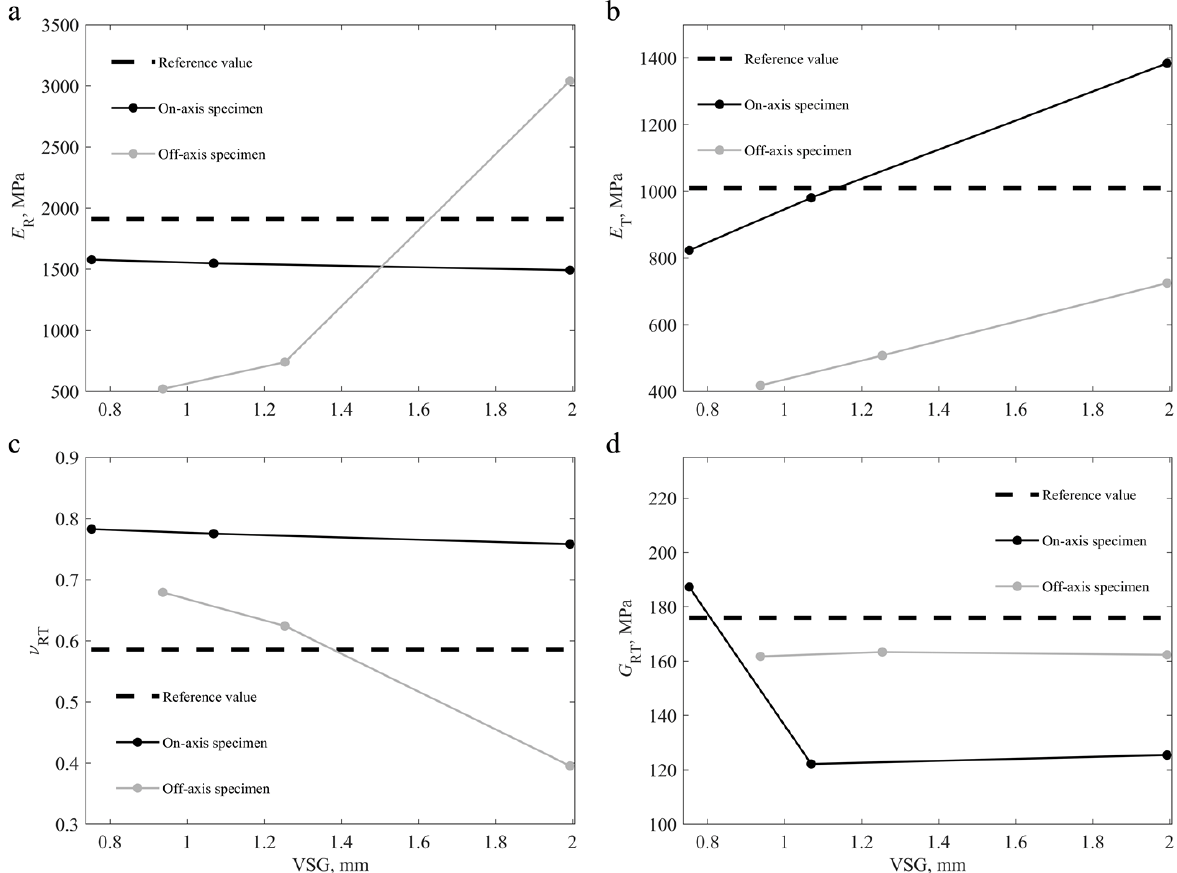
Figure 7. Results for the identification process for an on-axis and off-axis specimens using three different DIC settings (Table 2), and compared to the reference values [2,55], regarding the identified parameters: ( a ) E R ; ( b ) E T ; ( c ) ν RT ; ( d ) G RT